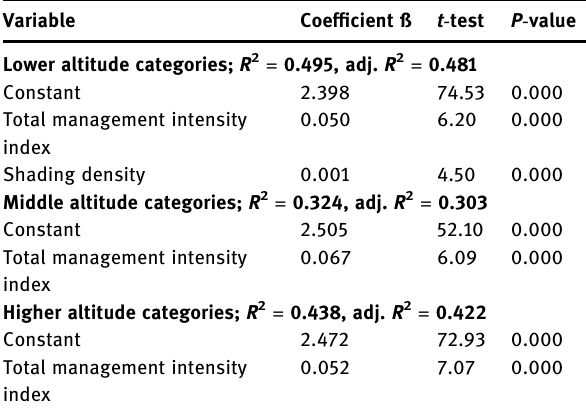
Table 4: Analysis of multiple regression of shade density and total management intensity index on co ff ee productivity at lower altitude category (> 1,000 – 1,200 m asl, n = 78 ) , middle altitude category (> 1,200 – 1,400 m asl, n = 84 ) , and higher altitude category (> 1,400 – 1,600 m asl, n = 72